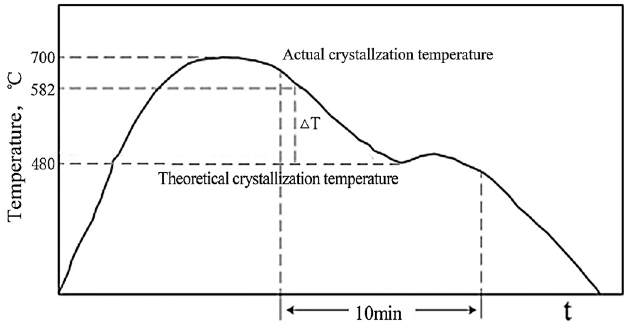
Figure 3. Schematic diagram of the action time of the ECP on the molten metal.